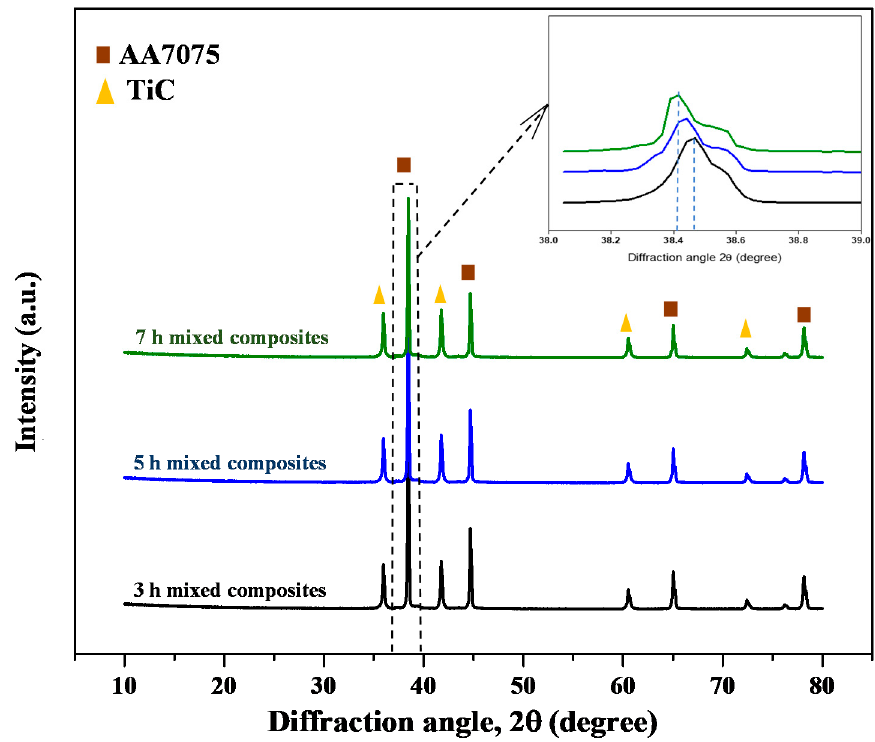
Figure 12. XRD spectrum of Al7075/4 wt.% TiC composite powders at different milling times. Insert reveals the shifts in Bragg’s angle.